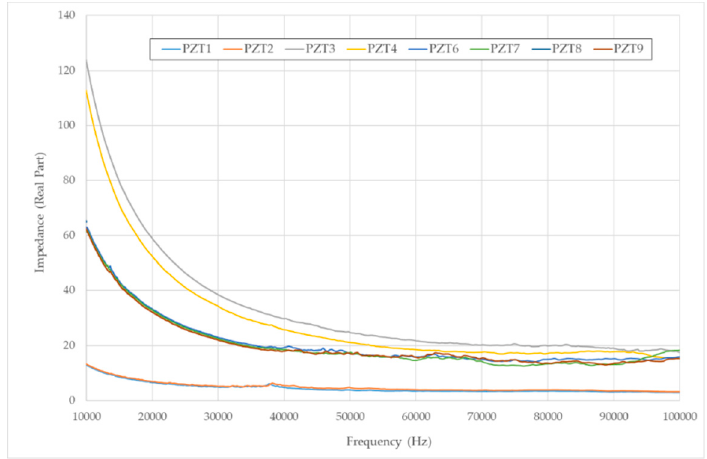
Figure 7. Impedance signals after the first loading stage—Specimen A.